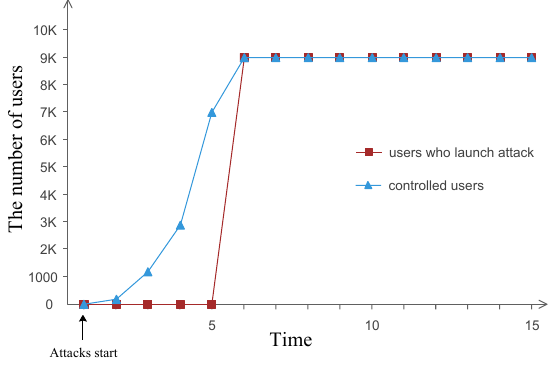
Figure 8. An example of a fast